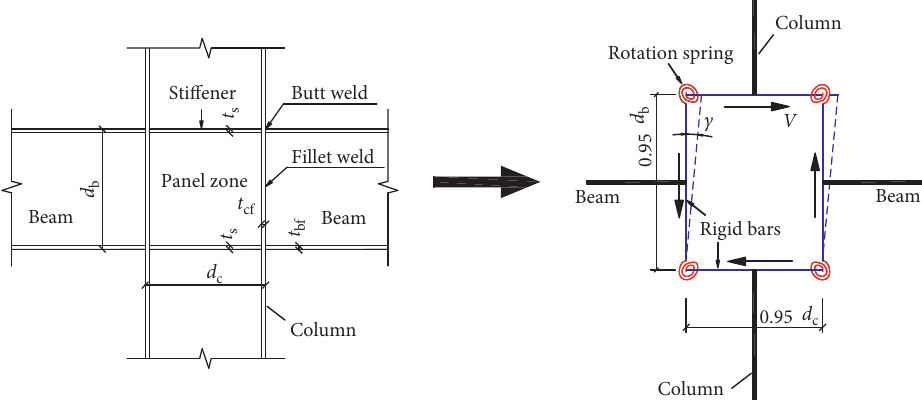
Figure 8: Schematic diagram of the KCM. Note. d b is the section height of the beam; d c is the section height of the column; t bf is the flange thickness of the beam; t cf is the flange thickness of the column; and t s is the thickness of the stiffness.